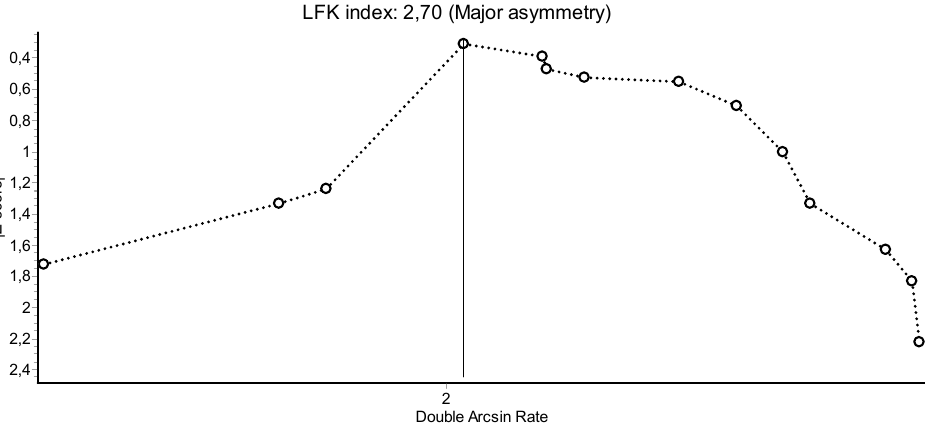
Figure A12. Doi plot analysis and Luis Furuya-Kanamori asymmetry (LFK) index of publication bias for the pooled work retention rate.